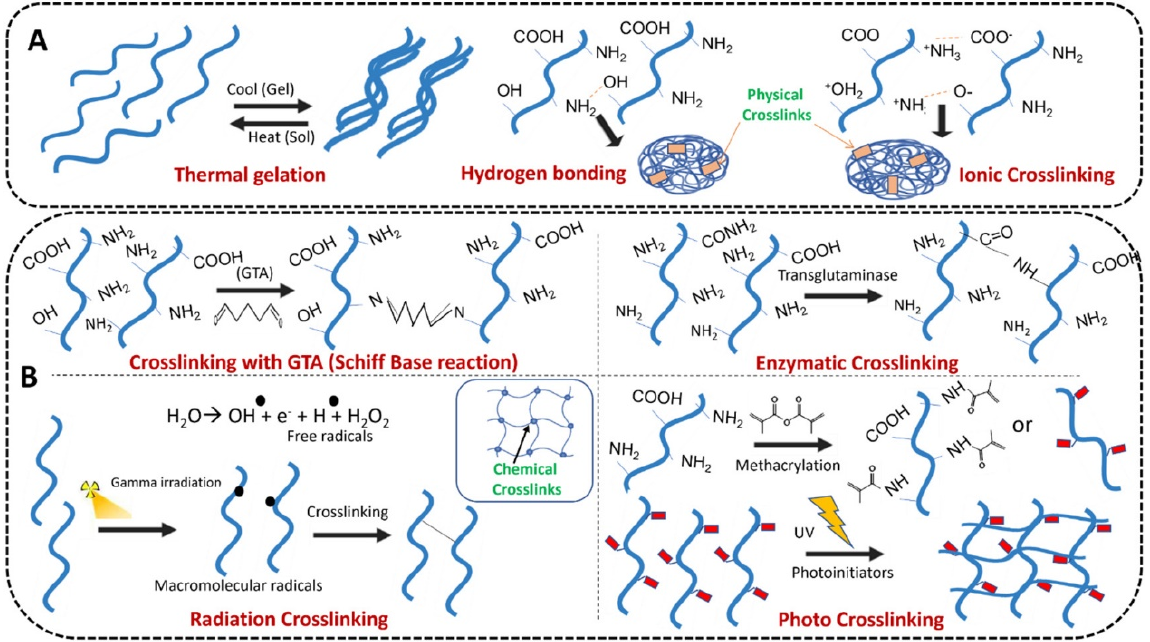
Figure 1. ( A ) physical and ( B ) chemical crosslinking techniques employed for gelatin hydrogel formation. Reprinted with permission from Ref. [10] Copyright 2022 Elsevier.